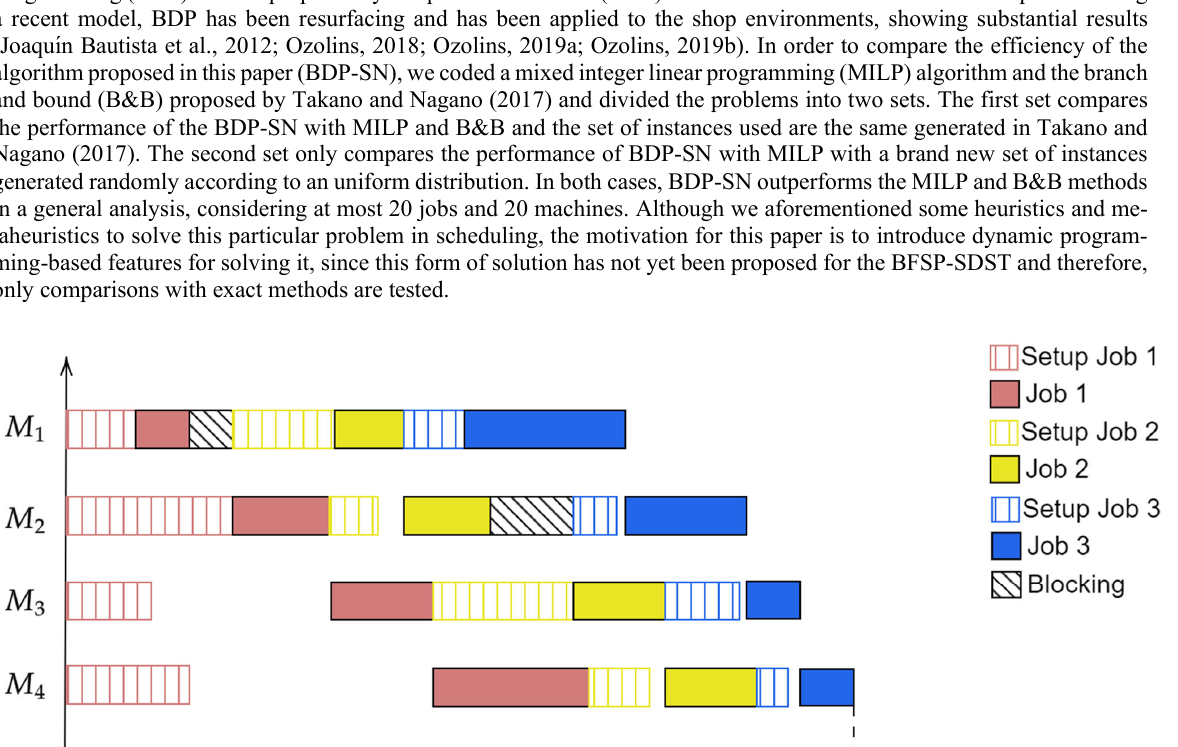
Fig. 1. Pictorial representation of the 𝐹𝑚 | 𝑠